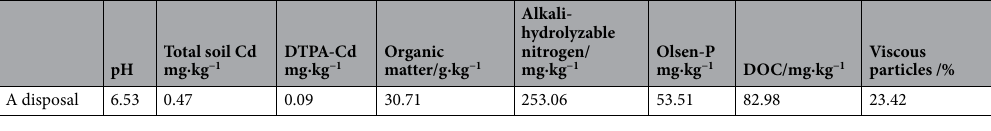
Table 1. Physical and chemical properties of the